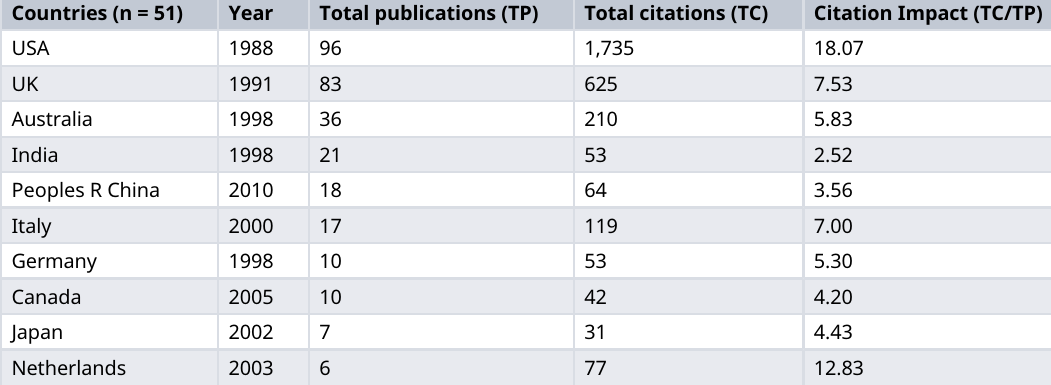
Table 4. Top ten contributing countries